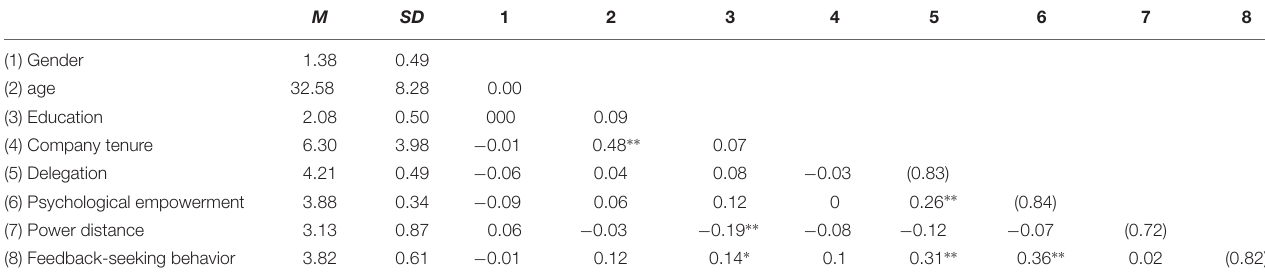
TABLE 1 | Means, standard deviations, and correlations.